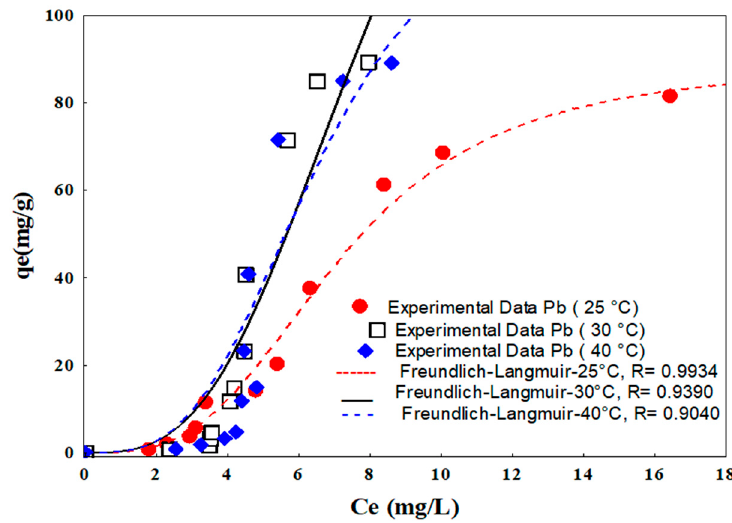
Figure 11. Pb adsorption isotherms onto FeNP/NFC composite at 25, 30, and 40 °C. Polymers are heterogeneous materials containing sorption sites with various binding affinities and selectivities [45]. Hence, it can be suggested that the FeNP/NFC adsorbent has a heterogeneous surface, and Pb and Cd sorption onto this composite may present a multi- layer behavior. The adsorption capacity of FeNP/NFC increased as the solute